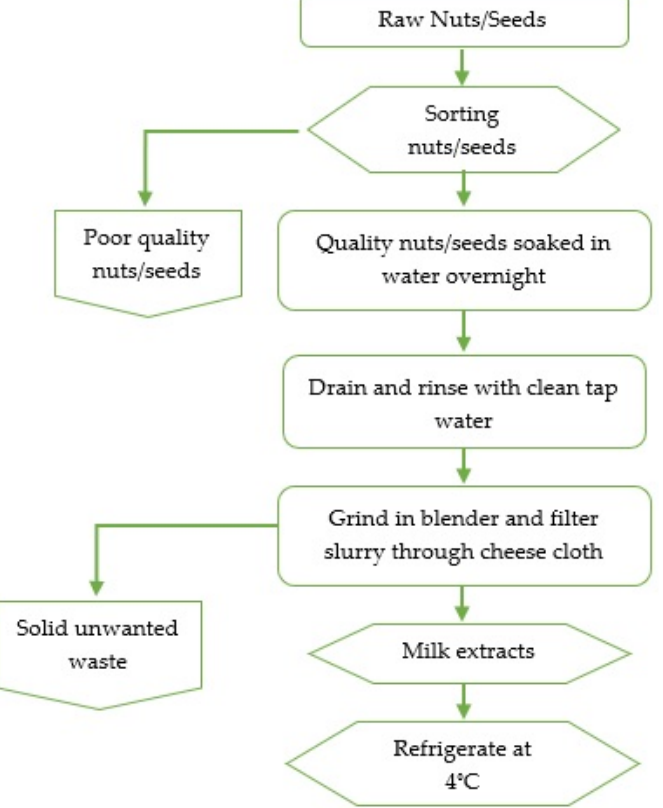
Figure 1. A schematic diagram for extracting milk from almonds, cashews, and soybeans. Enrichment of Milk and Bacterial Identification